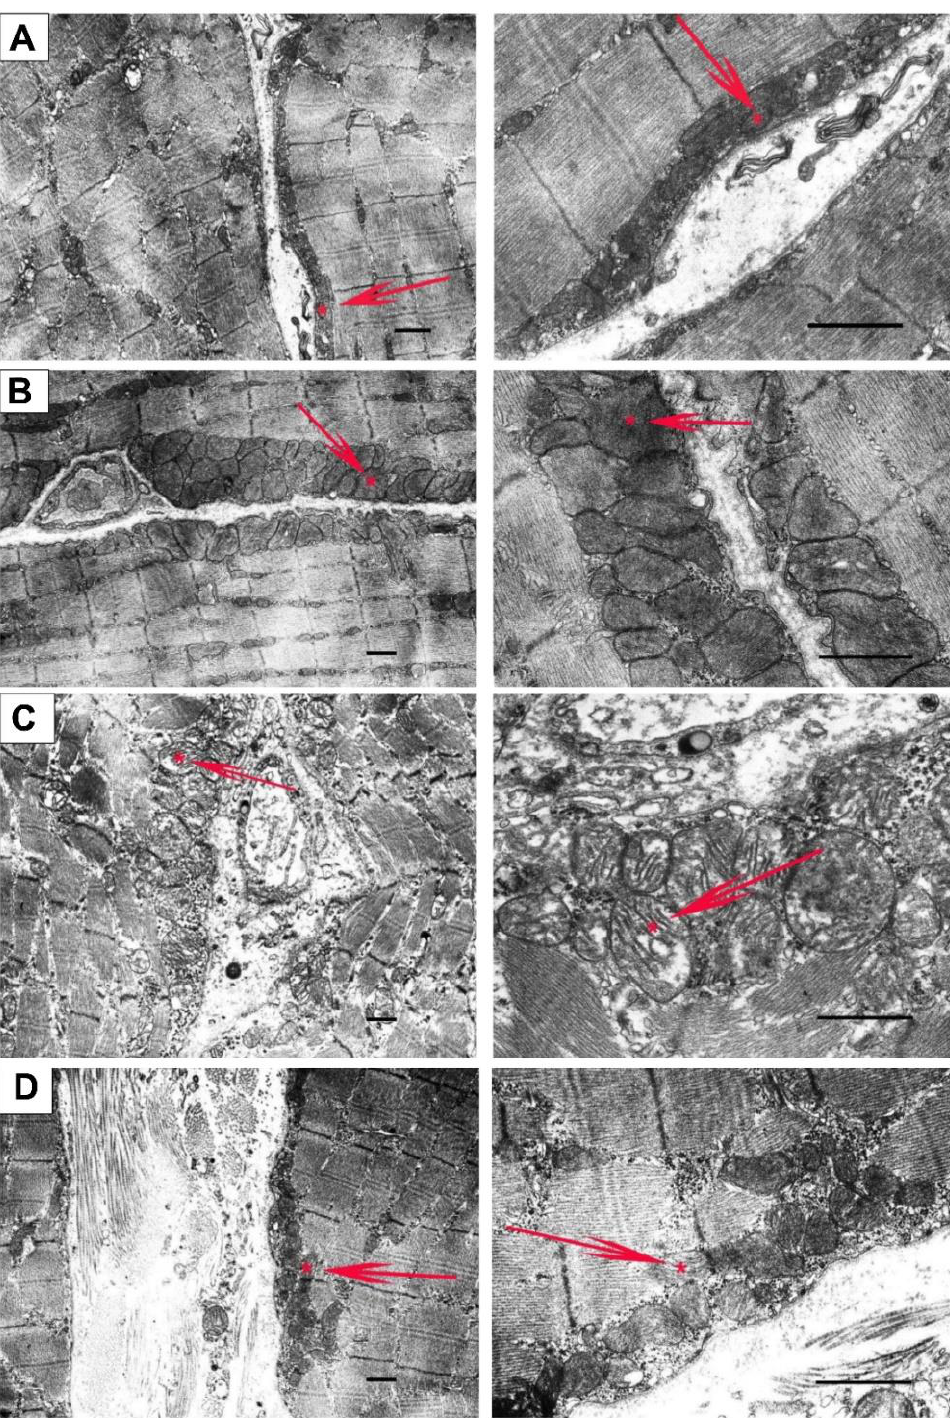
Figure 5. Representative electron micrographs of skeletal muscle tissue (quadriceps) from the WT ( A ), WT + NS1619 ( B ), mdx ( C ), and mdx + NS1619 ( D ) groups of mice. The red arrows highlight the subsarcolemmal population of mitochondria. An asterisk marks the same mitochondria at low and high magnification. The bar is equal to 1 μm.